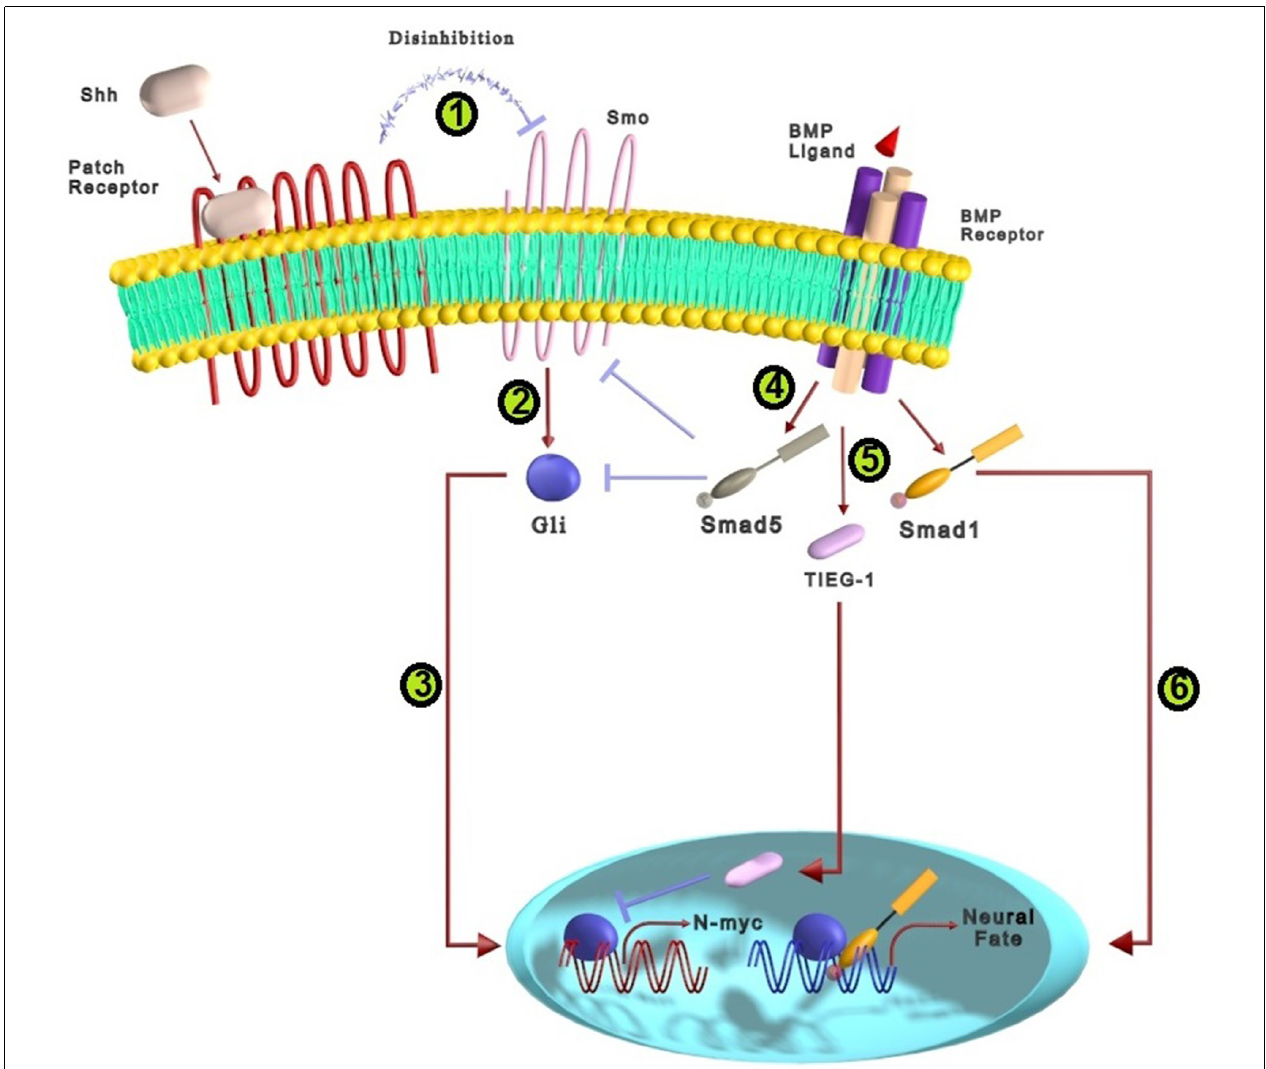
FIGURE 5 | The cross-talk between BMP and Shh signaling pathways in neural differentiation. (1) The complex of Shh ligands and Patch receptors trigger Shh signaling pathway by preventing inhibitory effects on Smo protein located within the membrane. (2) Smo activates the members of zinc-finger transcription factors called the Gli family. (3) The translocation of Gli proteins into the nucleus increases the transcription of genes that participate in the specification of neural cells. (4) BMPs can prevent the effects of Shh signaling by activating Smad5, which inhibits downstream agents of Shh such as Smo and Gli1. (5) TIEG-1, a BMP2 target gene, can suppress Gli-mediated transcription of N-myc, a critical Shh target gene, that prevents proliferation and promotes differentiation of granule cell precursors. (6) Smad1 interacts with C-terminally truncated Gli proteins and form a protein complex that contains Gli proteins which lead to neural